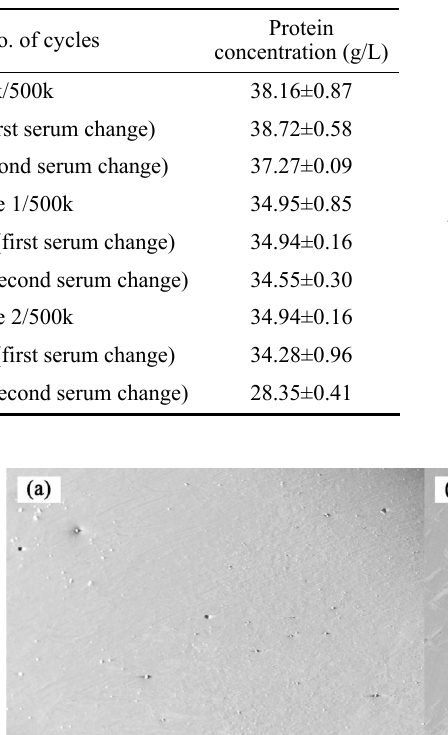
Table 1 Protein concentrations of soak and test stations during the test period.